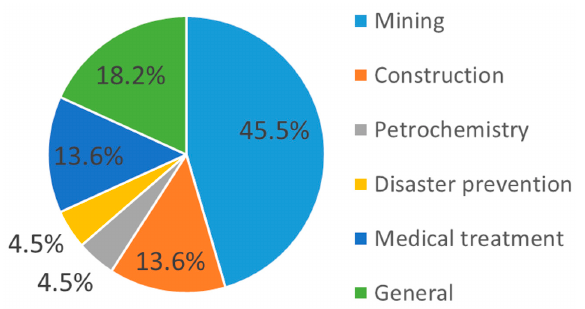
Figure 6. Percentage of smart helmet studies for workers by sub-category.